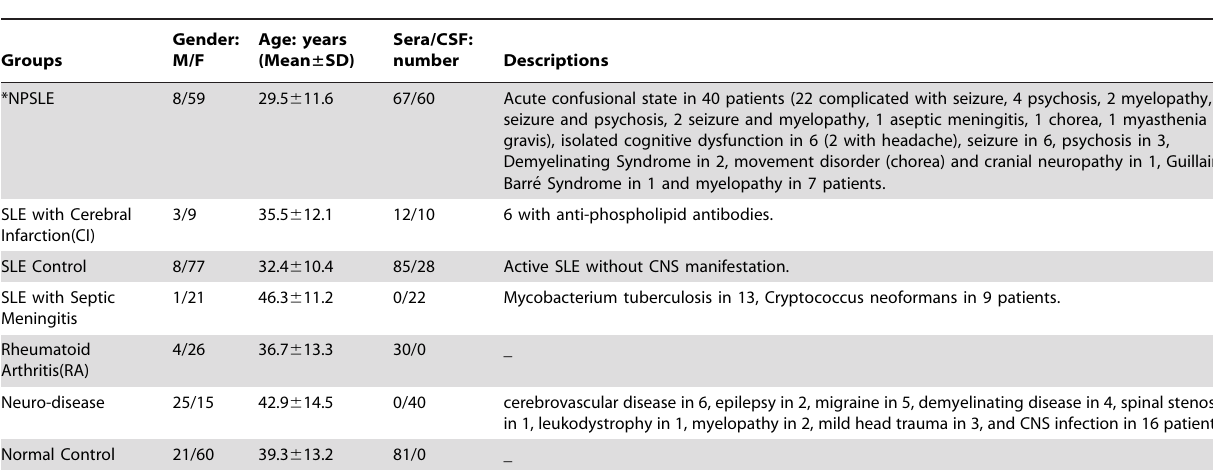
Table 1. Characteristics of the study